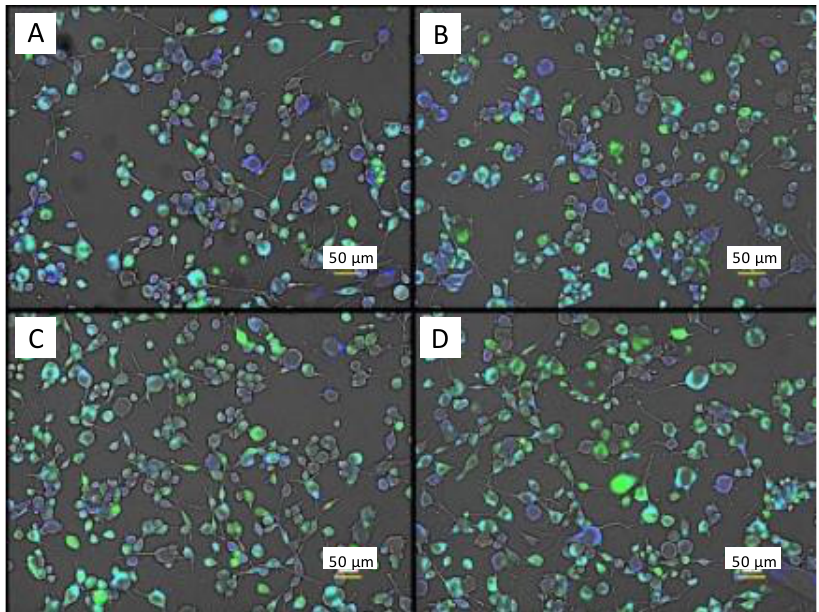
Figure 8. Fluorescence microscopy images of C6 glioma cells in the same plate in the presence of both 5 μM Ca 2+ probe (Fluo-4 AM, green) and 5 mM Cl − probe (MQAE, blue). Cyan denotes coexistence of Ca 2+ and Cl − in the cells. ( A ) PBS control cells. ( B ) PBS control cells after ES. ( C ) 10 mM L-glutamate. ( D ) 250 nM adenosine. Scale bars are 50 µm.